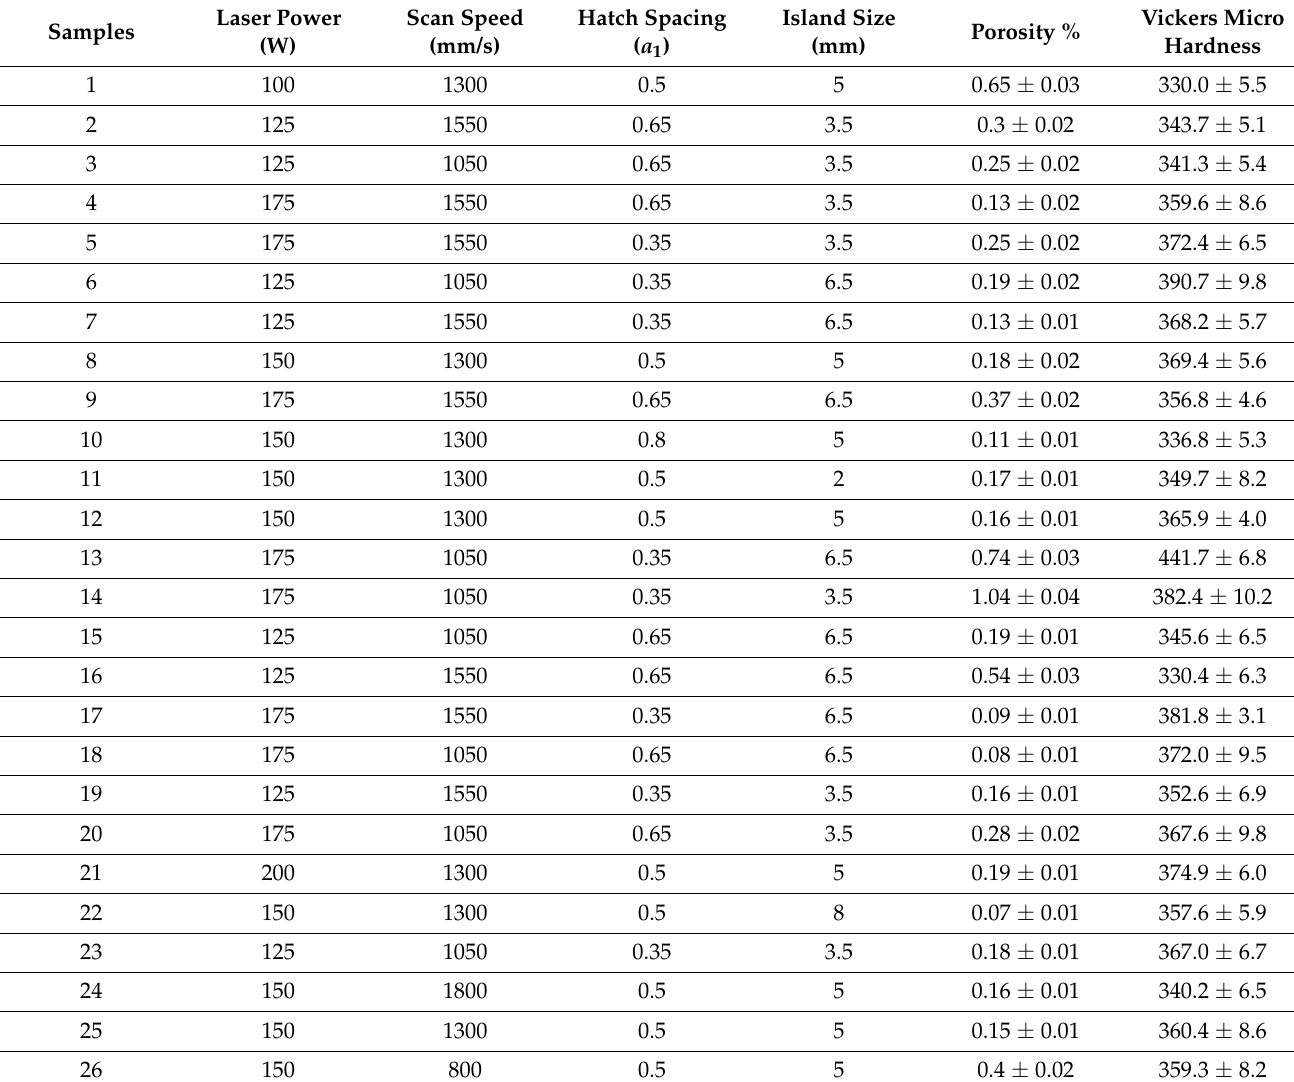
Table 2. The input parameters and response results.